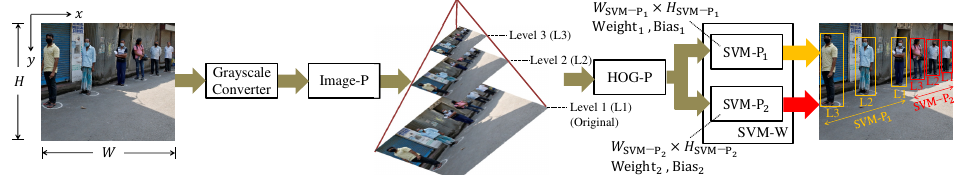
Figure 1. The general architecture of the PD system. The terms W , H , image-P, HOG-P, and SVM-P mean width, height, Image pyramid, HOG pyramid, and SVM